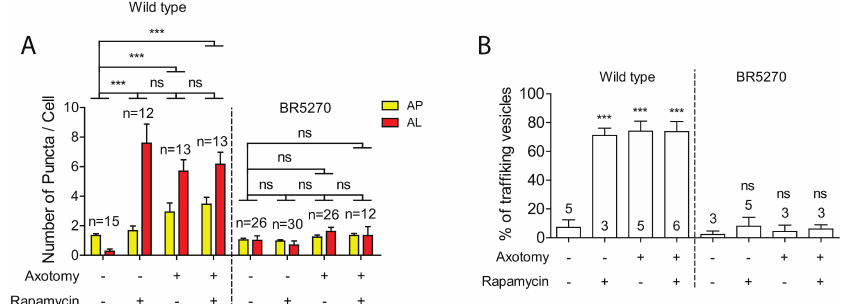
Figure 4. Defects in autophagic induction and tra ffi cking are not rescued by Rapamycin. ( A ) Quantification of autophagosomes (APs) and autolysosomes (ALs) in PLM cell bodies with indicated treatments. Rapamycin or axotomy alone was su ffi cient to enhance the numbers of APs and ALs in PLM neurons of wild type. In contrast, neither rapamycin nor axon injury was able to induce the formation of autophagic vesicles in PLM neurons of the Tauopathy model. ( B ) Quantification of autophagic vesicles movement in the PLM axons with indicated treatments. Rapamycin or axotomy alone was su ffi cient to enhance tra ffi cking in wildtype animals, but not in BR5270. Statistics: one-way ANOVA; mean ± SEM; *** p < 0.001; ns, Not